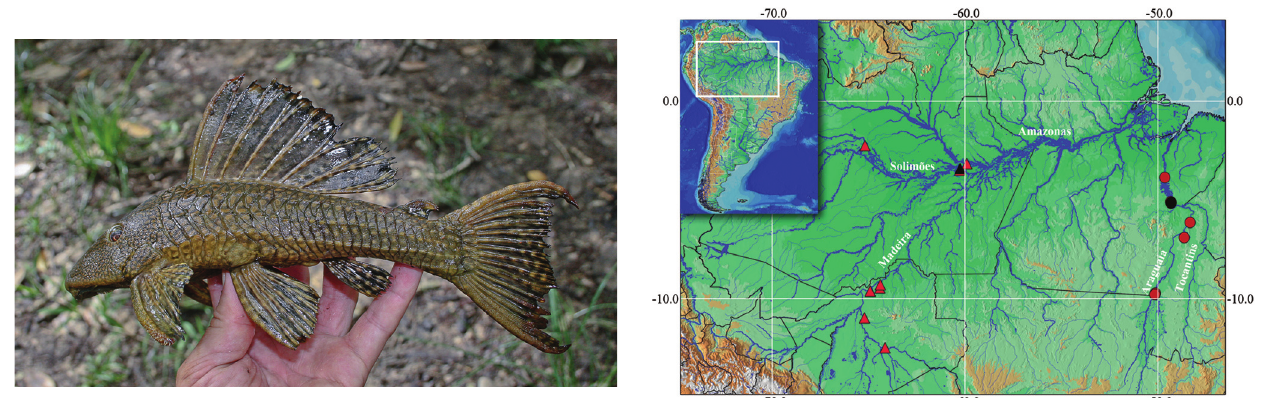
Fig. 4. Distribution of Hypostomus delimai new species (circle) and H . hoplonites Rapp Py-Daniel, 1988 (triangle). Black symbols represent type